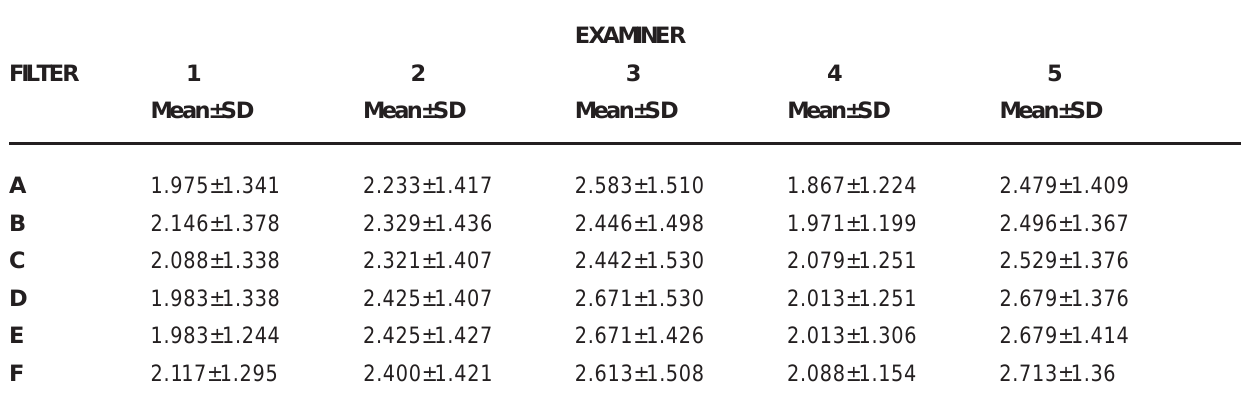
TABLE 3- Mean and SD of the values of the examiners using the same filter